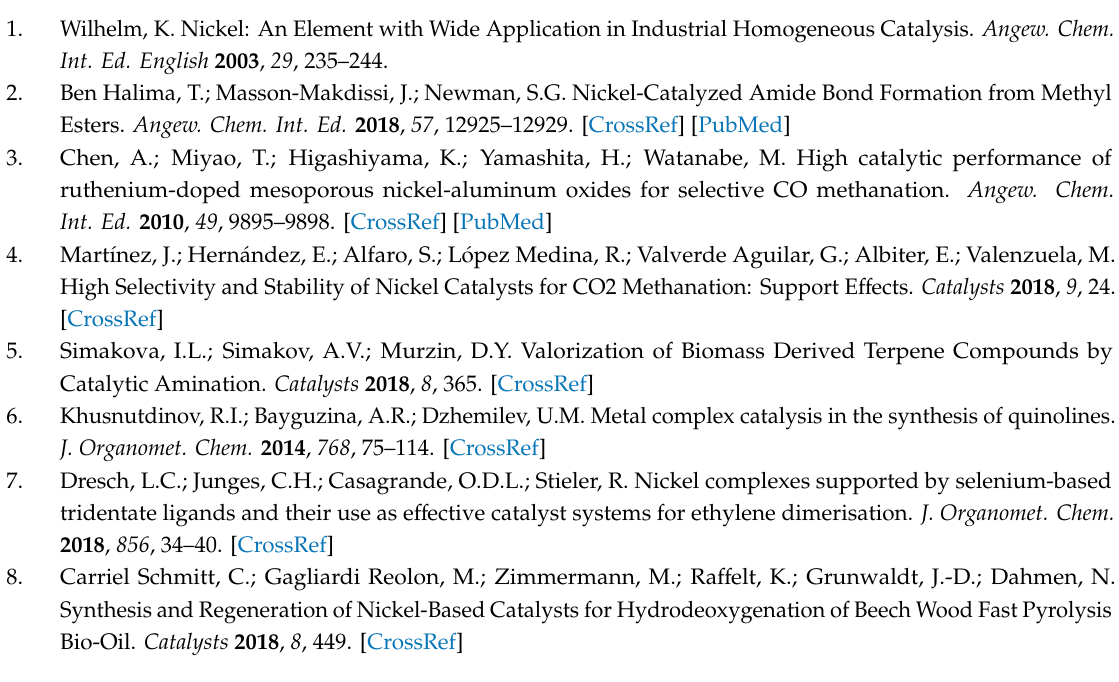
Figure S1: Mass spectrum of methyl-undecanoate at 6 min retention time, Figure S2: Mass spectrum